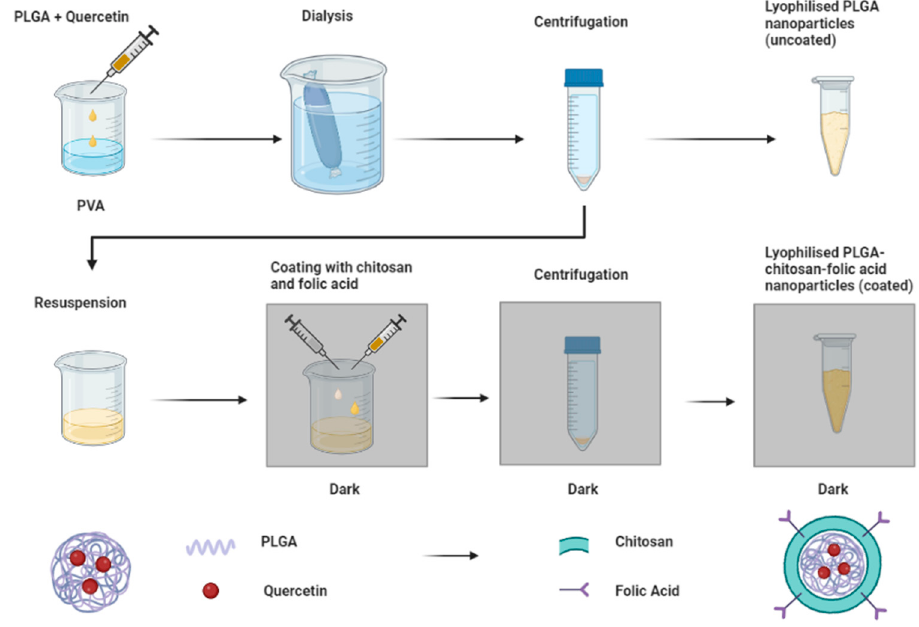
Figure 1. Fabrication process of uncoated (PLGA) and coated (PLGA-chitosan folic acid) nanoparticles.